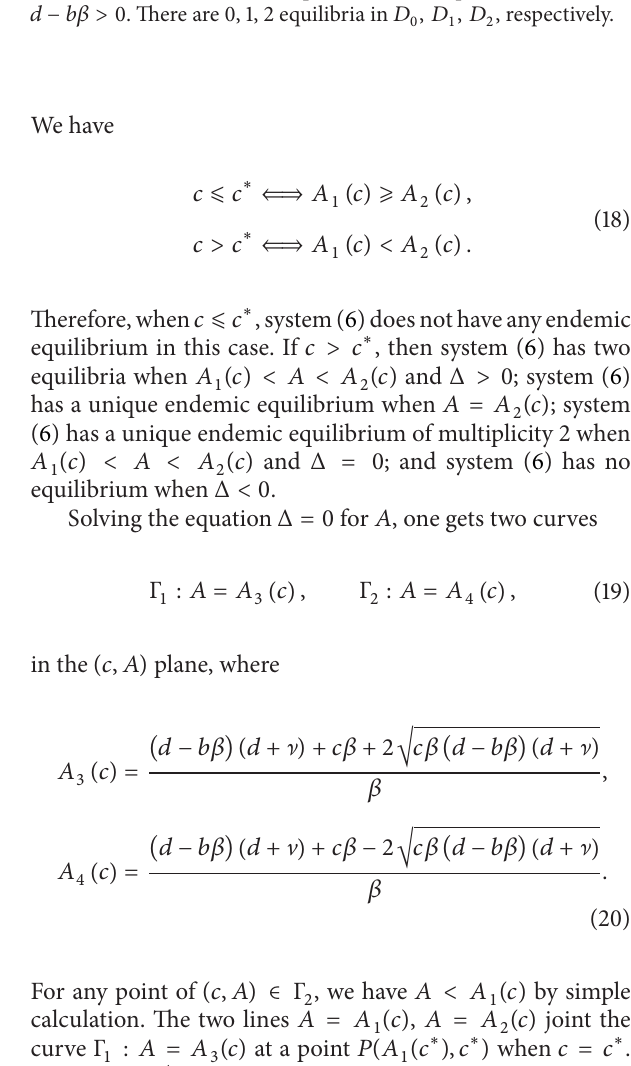
Figure2:Thedistributionofequilibriumontheplaneof (𝑐, 𝐴) when 𝑑 − 𝑏𝛽 > 0 . There are 0, 1, 2 equilibria in 𝐷